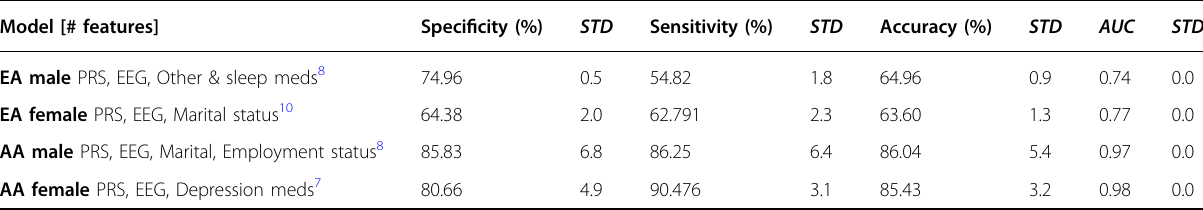
Table 1 Selected models predicting AUD remission strati fi ed by ancestry and sex. Model [# features]